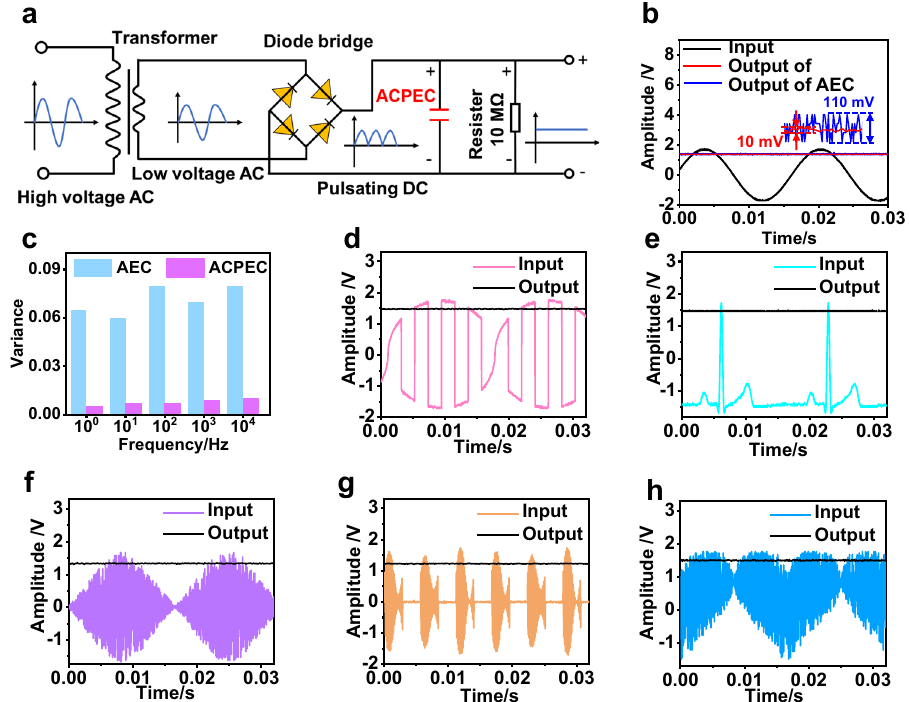
Fig. 3 | The fi ltering performance of an ACPEC unit. a Schematic demonstration ofthe fi lteringcircuit.Theresistanceofloadresistoris10M Ω . b ComparisonofAC line fi ltering performance of the ACPEC with that of the commercial AEC (220 μ F/ 16V, CHONGX, China) at 60Hz. Inset shows the fl uctuations of the DC voltage outputsignalsofACPECunitandAEC(220 μ F/16V,CHONGX,China). c Histogram of variance of the output signals data of ACPEC and AEC versus frequency in the